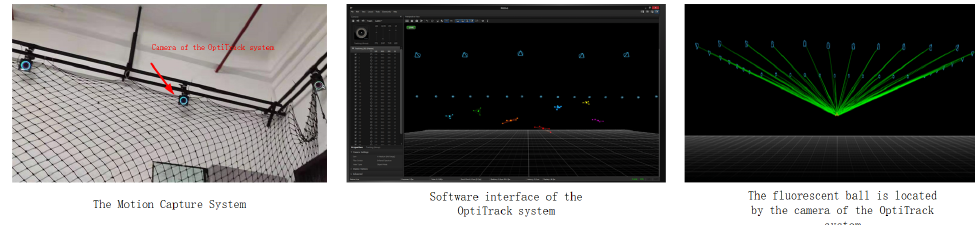
Figure 10. The Motion Capture System, OptiTrack, and its corresponding software